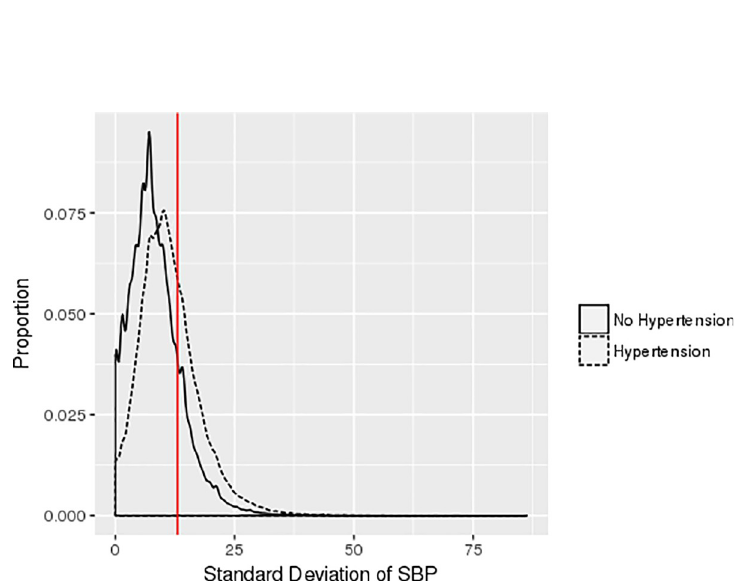
Fig 1. Average standard deviations between visits for systolic blood pressure in patients with vs. without hypertension. Legend: Each data point represents the mean SD for one patient’s SBP between visits. The mean SD for SBP in individuals without hypertension was 8.2 and for hypertensive patients was 11.3. The red line represents a SBP SD of 13.0 mm Hg (thus values to the right of this represent patients with “high BPV”).